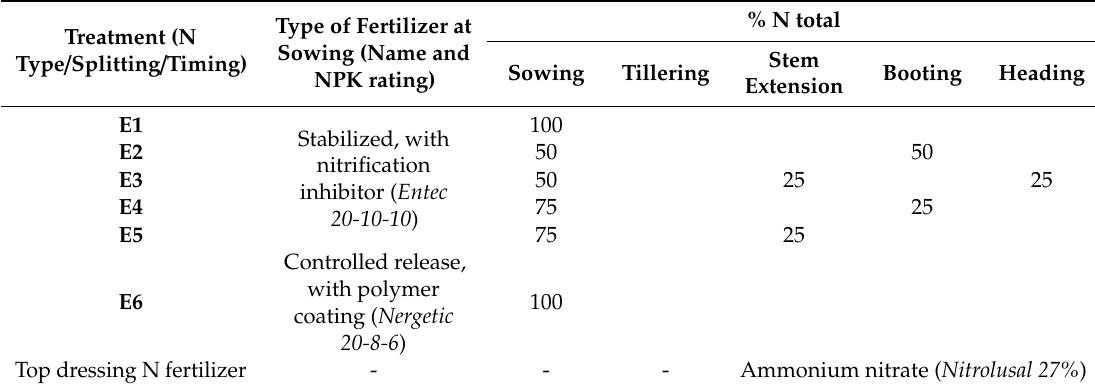
Table 4. Nitrogen fertilizer type, splitting (% of N total) and timing (phenological stage) treatments through the wheat cycle in Trial 1 (2016 / 2017), with Enhanced E ffi ciency N fertilizers. Crop stages dates between brackets. N – Nitrogen; P – Phosphorus; K –